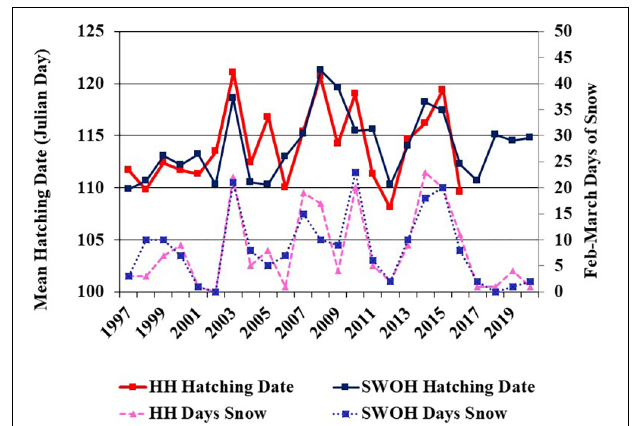
FIGURE 2 | Annual mean hatching date for Red-shouldered Hawks and number of days of snow cover in February–March in southwest Ohio (SWOH) and Hocking Hills (HH) study areas in southern Ohio, United